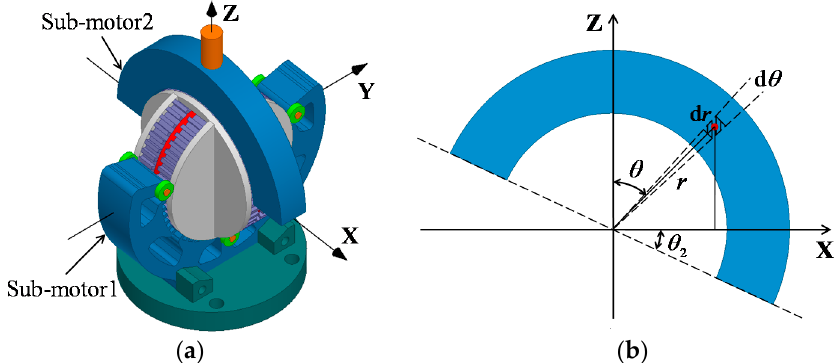
Figure 23. Simplified motor model for unbalanced force analysis. ( a ) 2-DOF motor with simplified stator of sub-motor2; ( b ) Equivalent mass surface of the stator of sub-motor2.